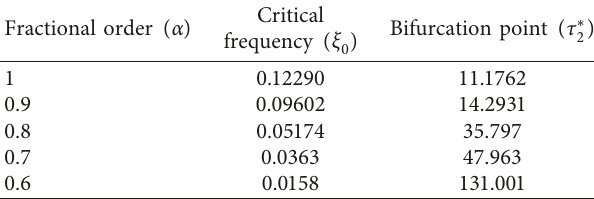
Table 2: ξ values and τ ∗ values for different fractional-order α . 0 2